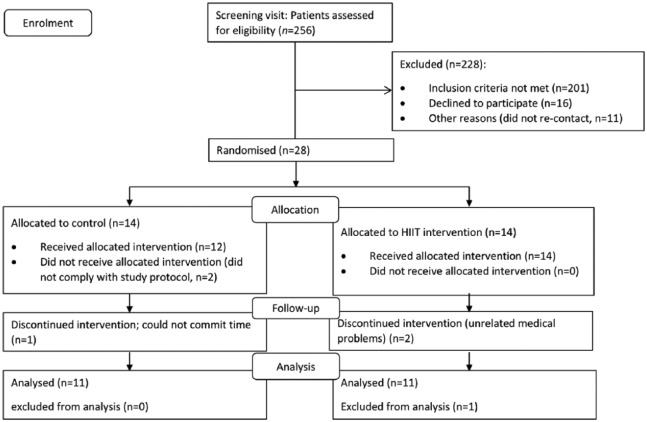
Consort flow diagram showing patient enrolment.